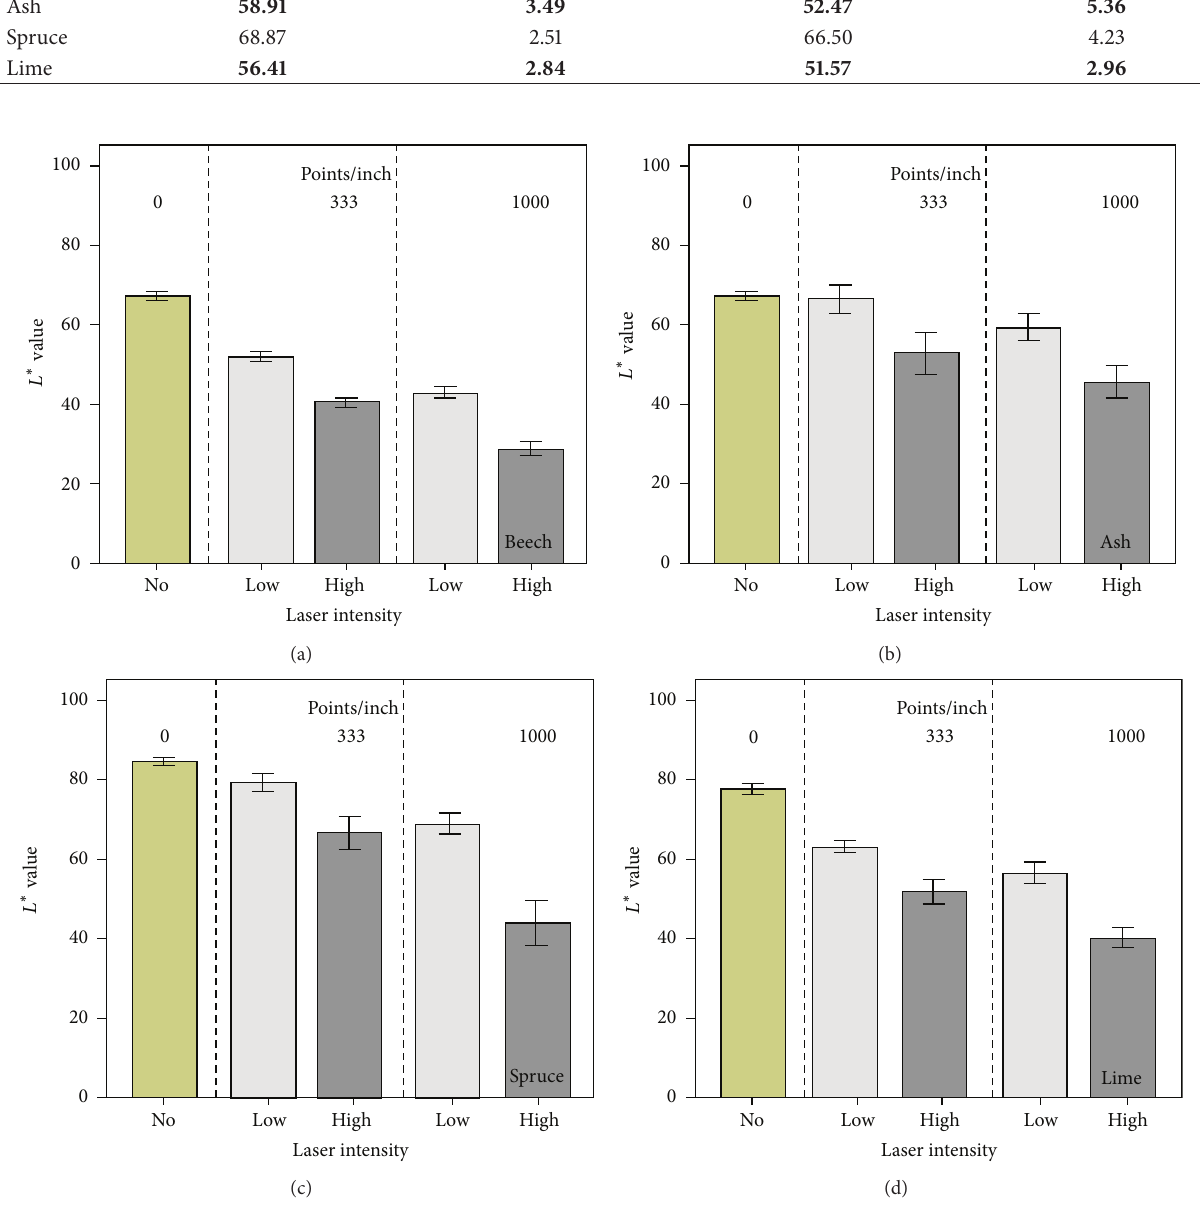
Figure 2: Results of the 𝐿 ∗ value measurement for the wood species observed (for the different laser parameter